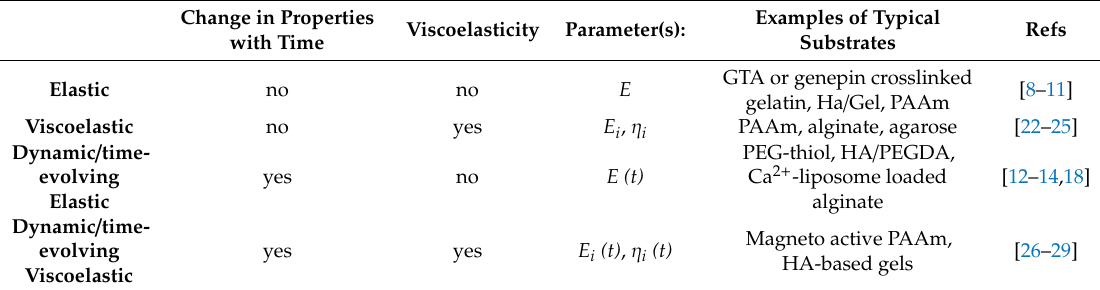
Table 1. Summary of cell culture substrate mechanical properties and their time dependence (or viscoelasticity) and time evolution (or change in properties with